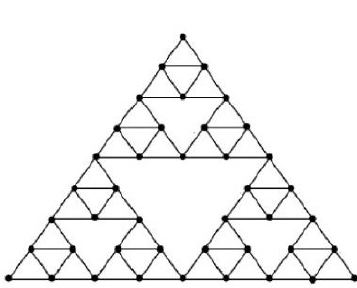
Figure 11. Sierpinski Network (S n ).